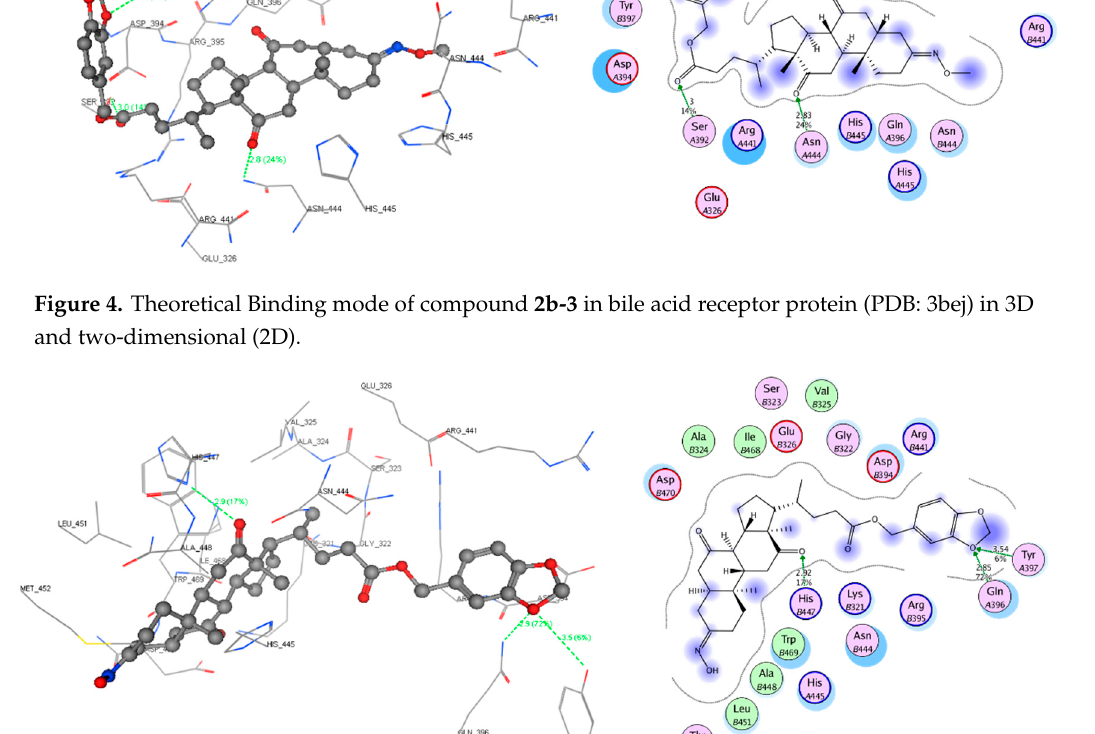
Figure 5. Theoretical Binding mode of compound 2b-1 in bile acid receptor protein (PDB: 3bej) in 3D and 2D.